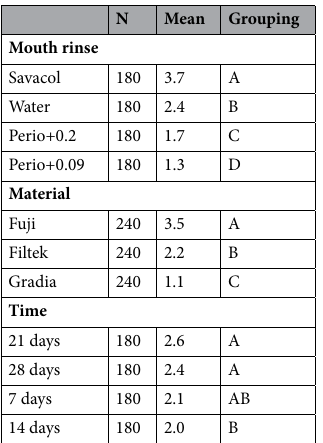
Table 1. Summary of GLM analysis of ΔE 00 data for factors “mouth rinse”, “material” and “time”. Means that do not share a letter are significantly different. Grouping information using Tukey method and 95.0% confidence. N number of observations, mean mean ΔE 00 of each group within each